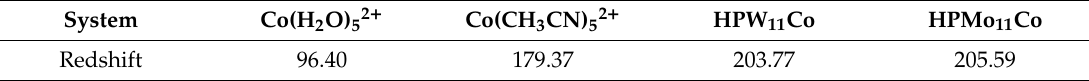
Table 3. The di ff erence (redshift) between the vibration wave number [cm − 1 ] of O-O bond in the O 2 molecule, before and after adsorption of O 2 on the cobalt center in the studied